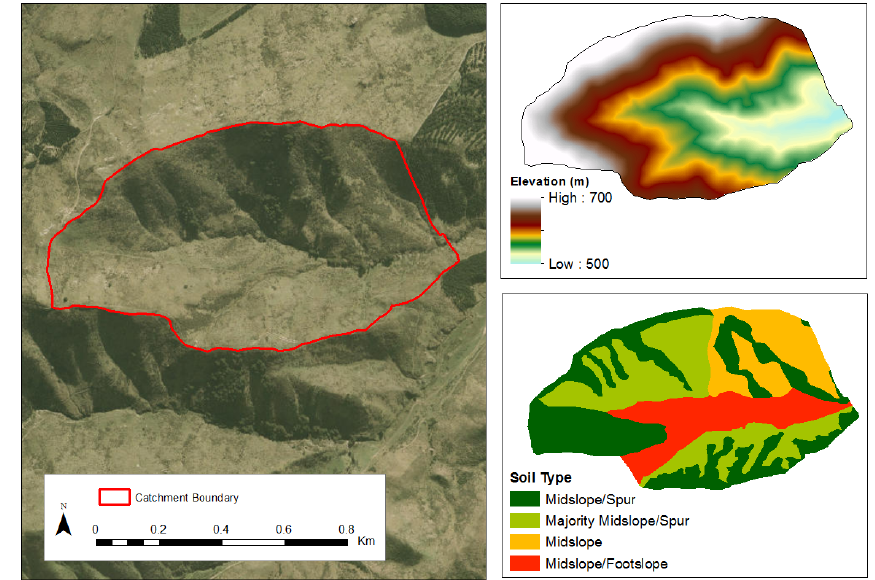
Figure 2. Catchment aerial photo, topography and